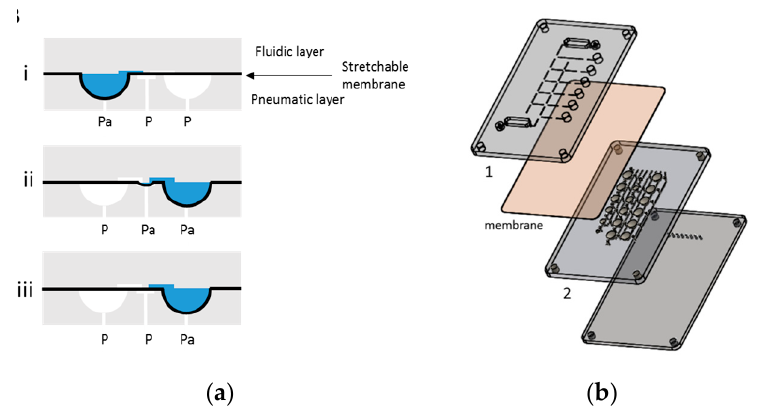
Figure 1. Hybrid cartridge made from 2 plastic cards and a stretchable membrane. ( a ) Schematic cross sectional view of fluidic actuation; ( b ) Perspective view of cartridge technology.